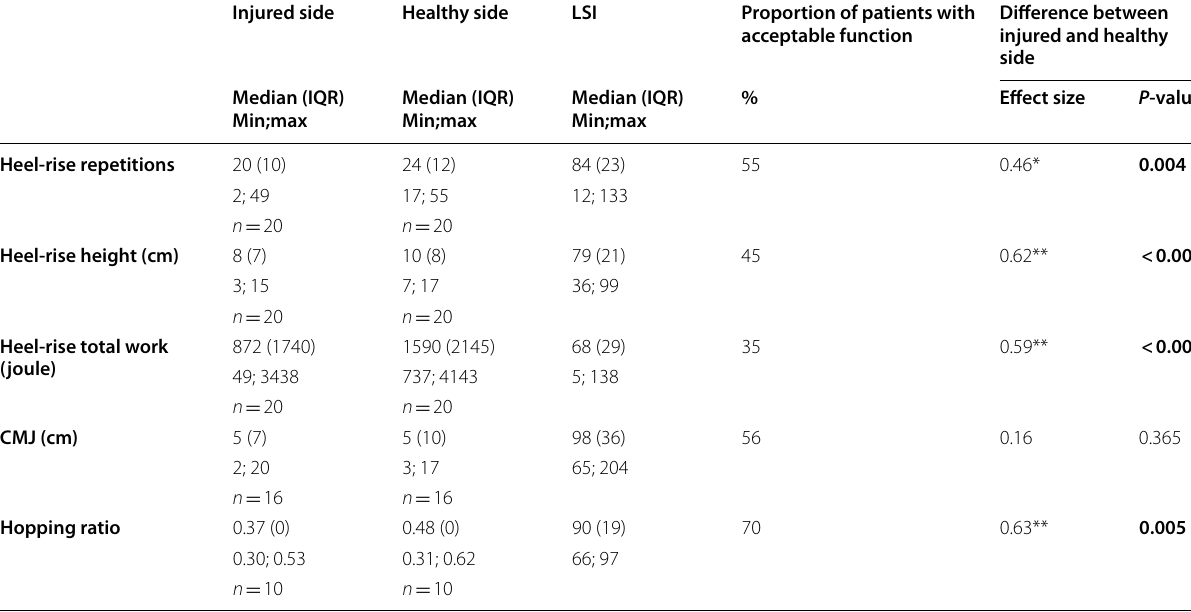
Table 3 Muscle function in patients with CATR